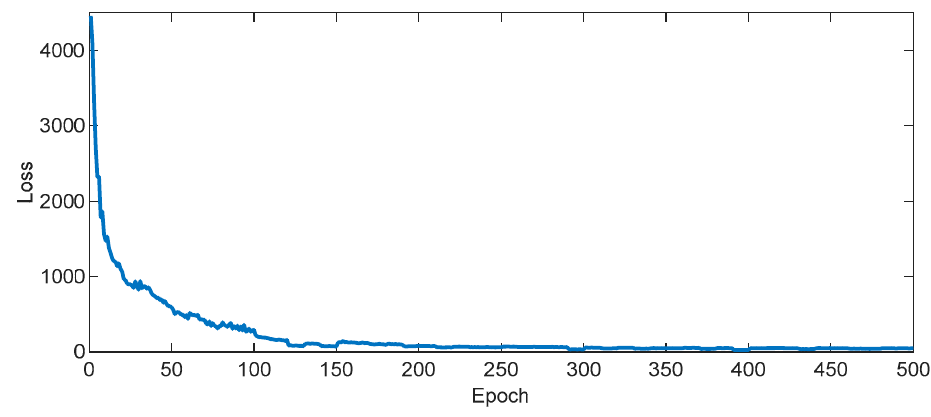
Figure 8. Convergence curve of the loss function.